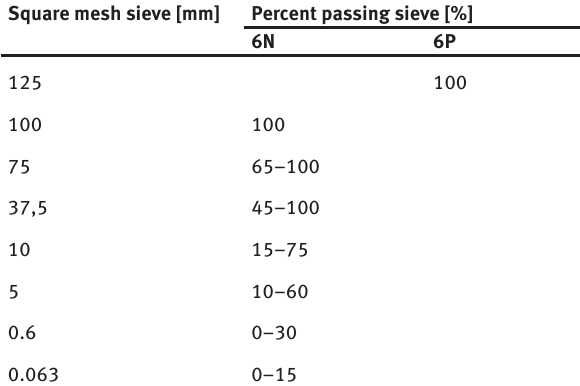
Table 2. Grading of 6N and 6P class backfills [14].